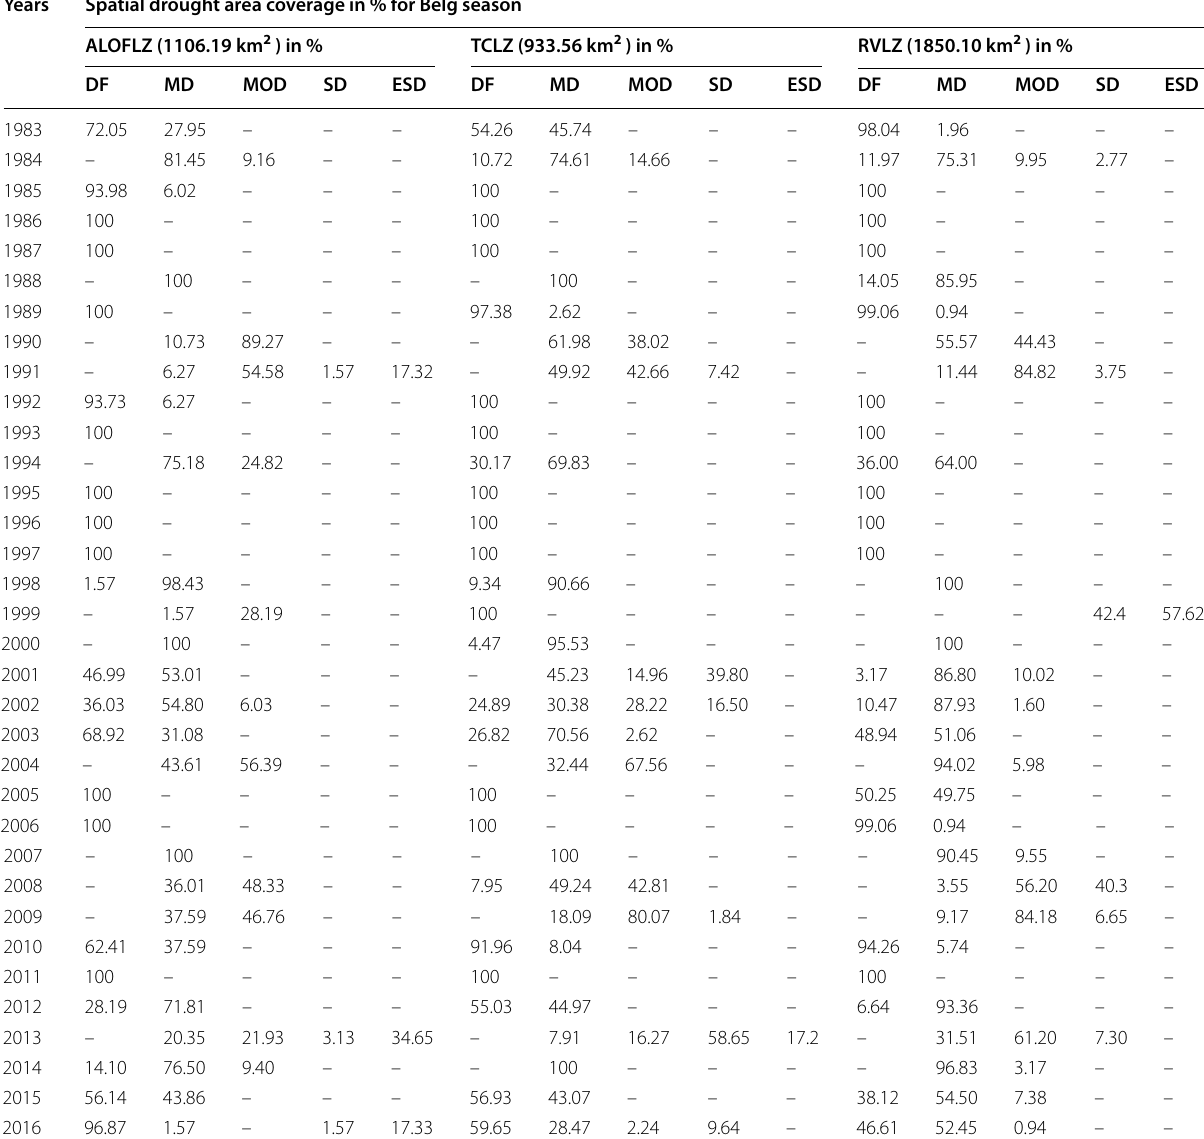
DF Drought Free, MD Mild Drought, MOD Moderate Drought, SD Severe Drought, ESD Extremely Severe Drought, ( – ) Zero value